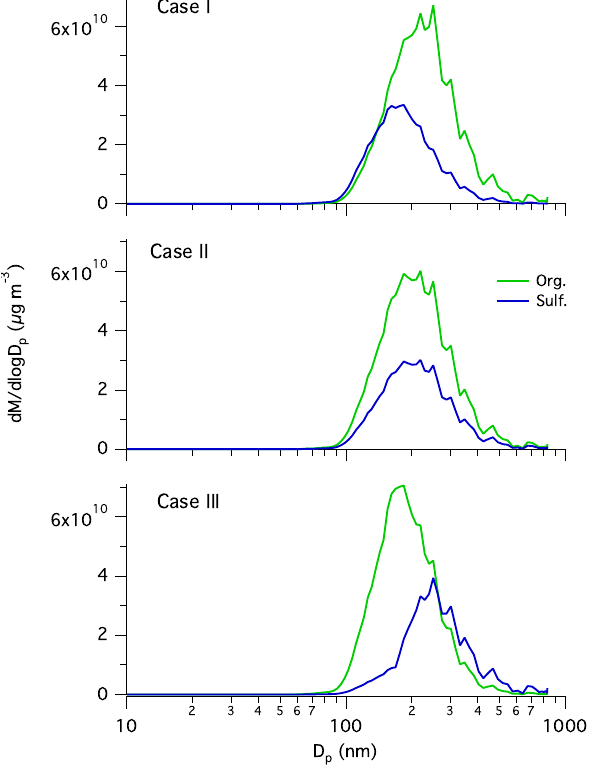
Fig. 12. Organic and sulfate mass distributions used in a simulation to assess the effect of size-dependent r OS on the upper bound or- ganic mass wall loss correction. All mass distributions are derived from the same observed particle number distribution and have r OS of 2.00 and an organic mass concentration of 22.7–22.8 µgm − 3 . Case I is representative of condensation governed by gas-particle equilibrium partitioning (see text), and Case III is representative of condensation governed by diffusion-limited growth (see text). In Case II, r OS is constant for all D p .